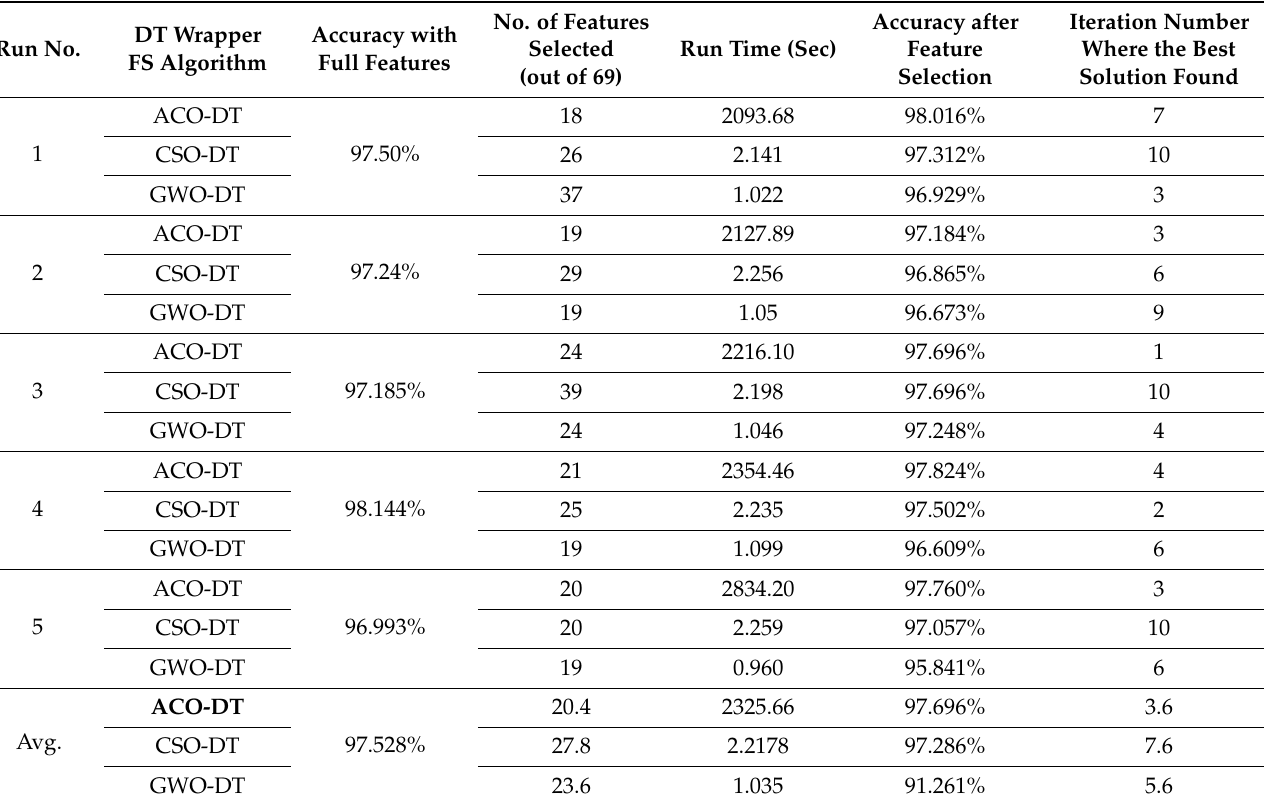
Table 12. Evaluation of ACO-DT, CSO-DT, and GWO-DT on the benchmark ClaMP dataset.